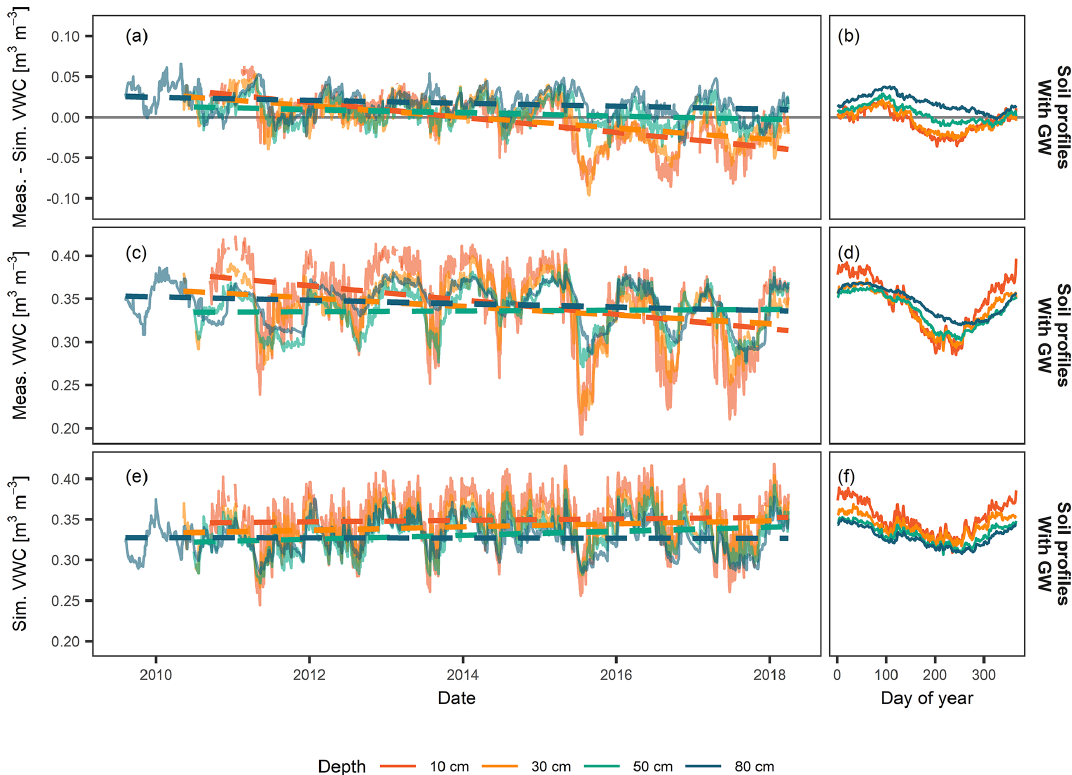
Figure 5. Temporal evolution of, and seasonal variation in, mean daily residual volumetric water content (VWC) (a, b) , i.e. the deviation between simulated and observed soil water content, and mean daily measured (c, d) and simulated VWC (e, f) . Means are calculated across all 14 reference sites by sensor depths (different colours) for a CoupModel set-up using soil hydrological properties derived from SoilGrids and a lower boundary condition with